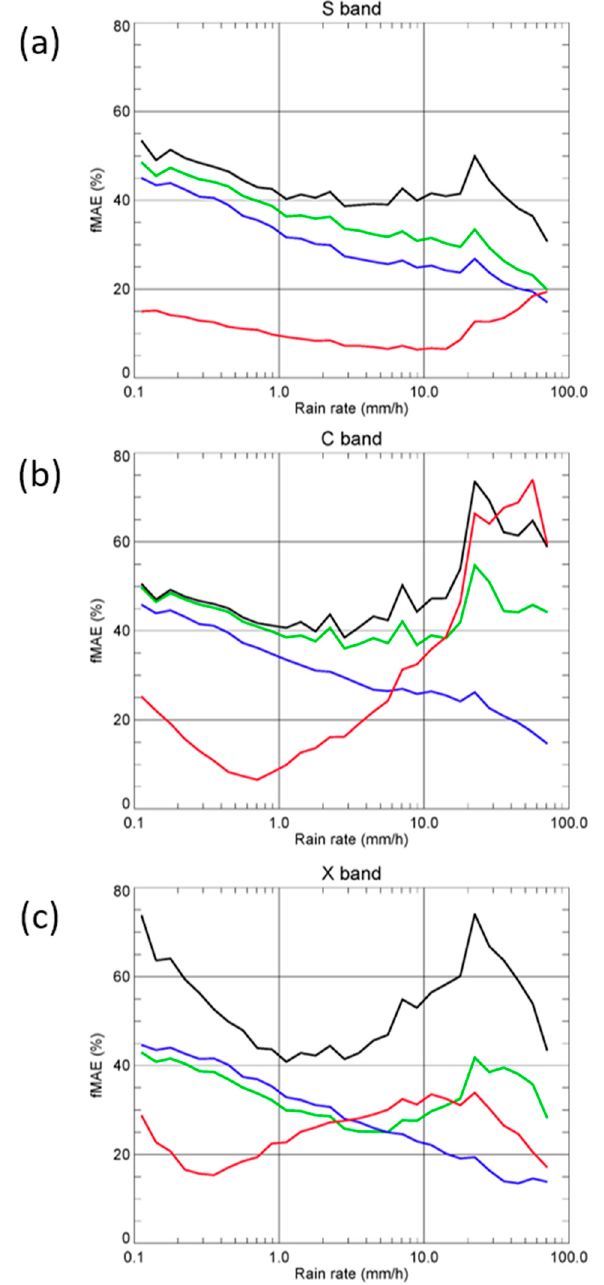
Figure 4. Dependencies of the fractional mean absolute error (fMAE) on rain rate for the R(Z) (black curves), R ( Z,Z DR ) (green curves), R ( K DP ) (blue curves), and R(A) (red curves) relations optimized for the Oklahoma DSDs at S, C, and X bands (panels ( a ), ( b ), and ( c ), respectively